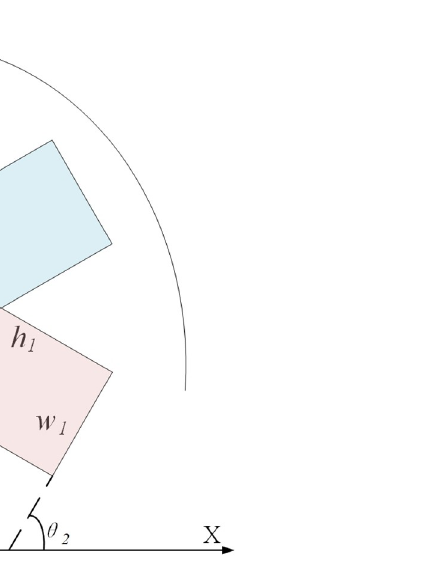
Fig 5. Rotation angle diagram of rotating anchor